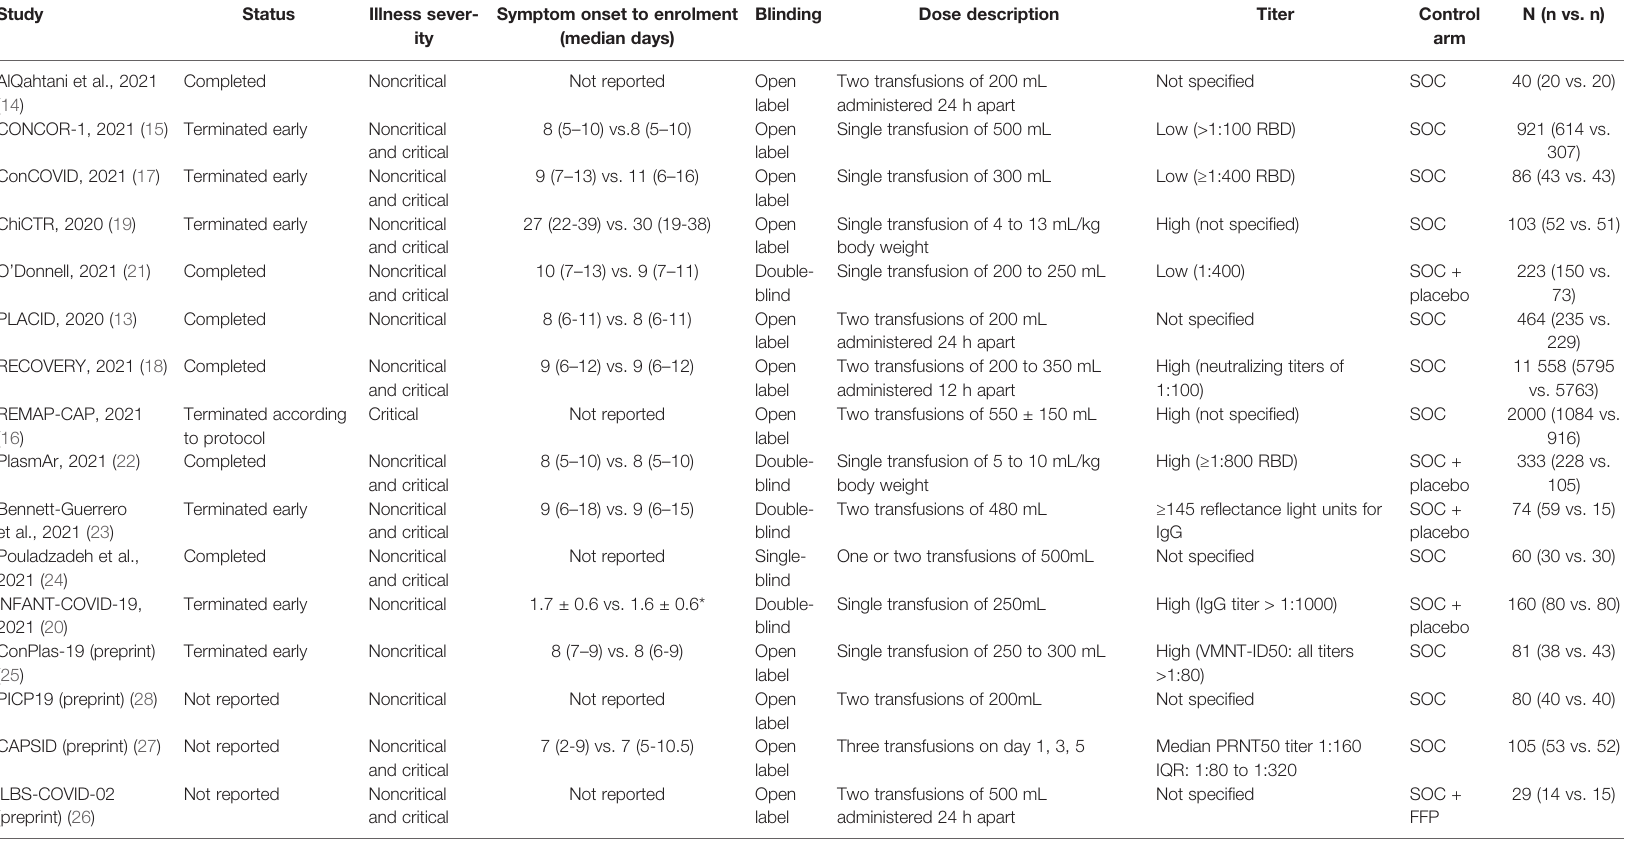
TABLE 1 | Characteristics of the included